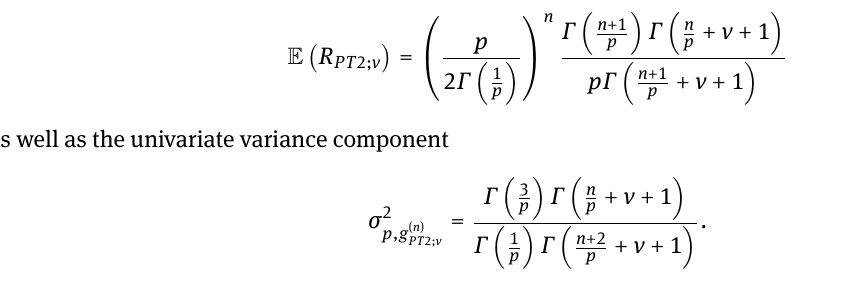
w.r.t. B n , p are computed for q ∈ { 0.9, 0.95, 0.99, 0.995, 0.999 } , p = 1 and for several